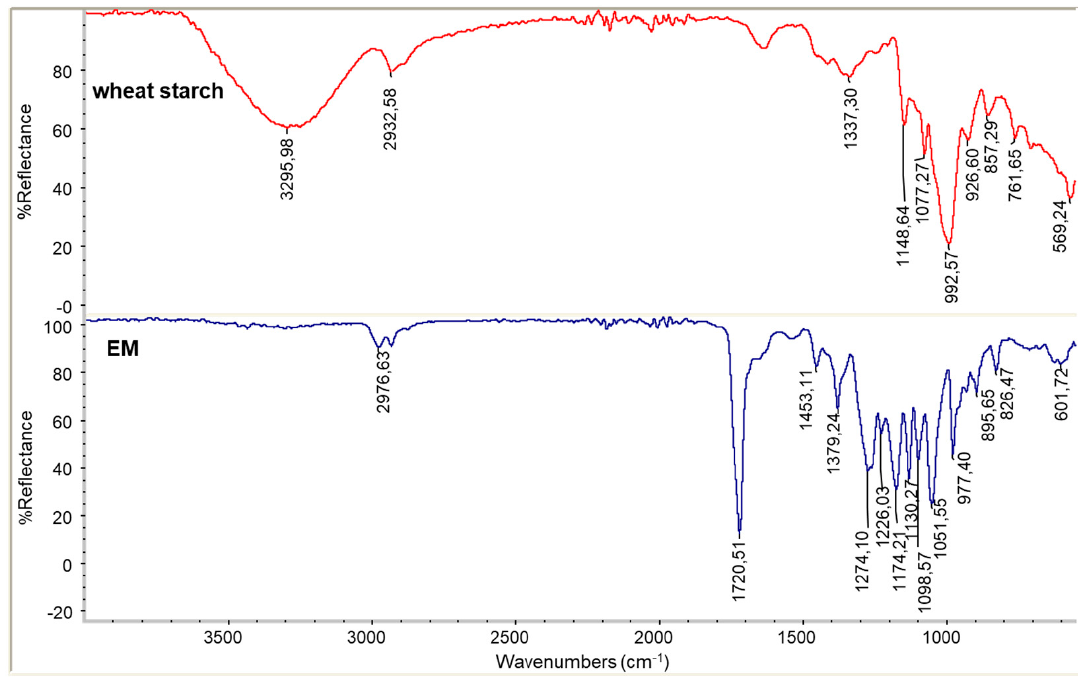
Figure 2. Infrared ATR spectra of wheat starch powder and EM PHA.